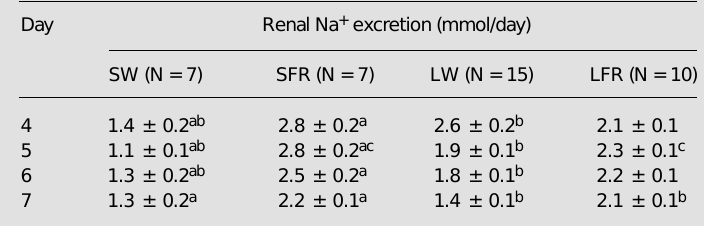
Table 3 - Renal sodium excretion (mmol/day) from the fourth to the seventh day after tumor cell inoculation in sham-operated tumor-bearing (SW; N = 7) and septal-lesioned tumor-bearing (LW; N = 15)